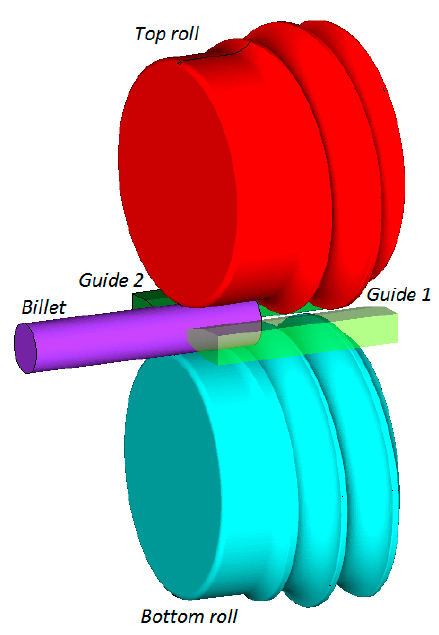
Figure 9. Virtual model of the analyzed rolling method for manufacturing ∅ 40 mm balls.